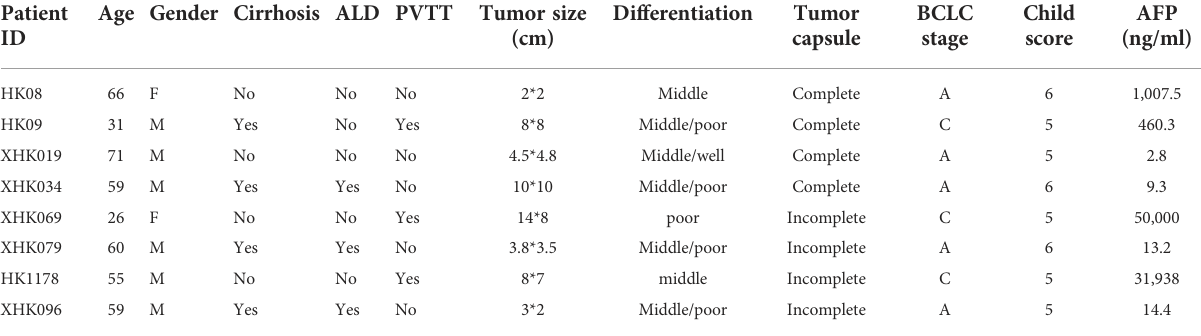
TABLE 1 Clinical information of HCC